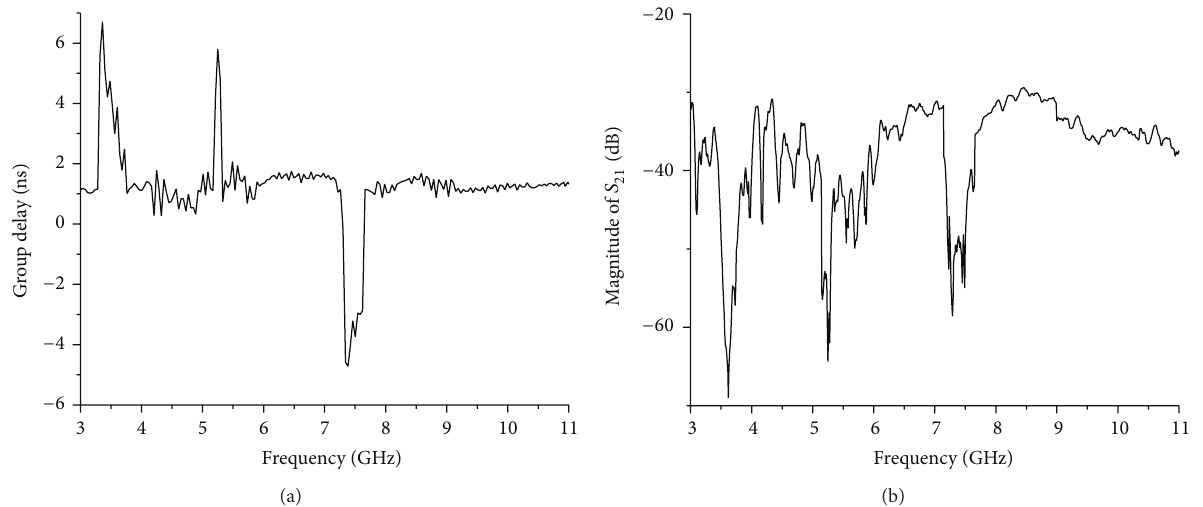
Figure 13: Time domain characteristics of the proposed antenna. (a) Group delay, (b) magnitude of the transfer function.